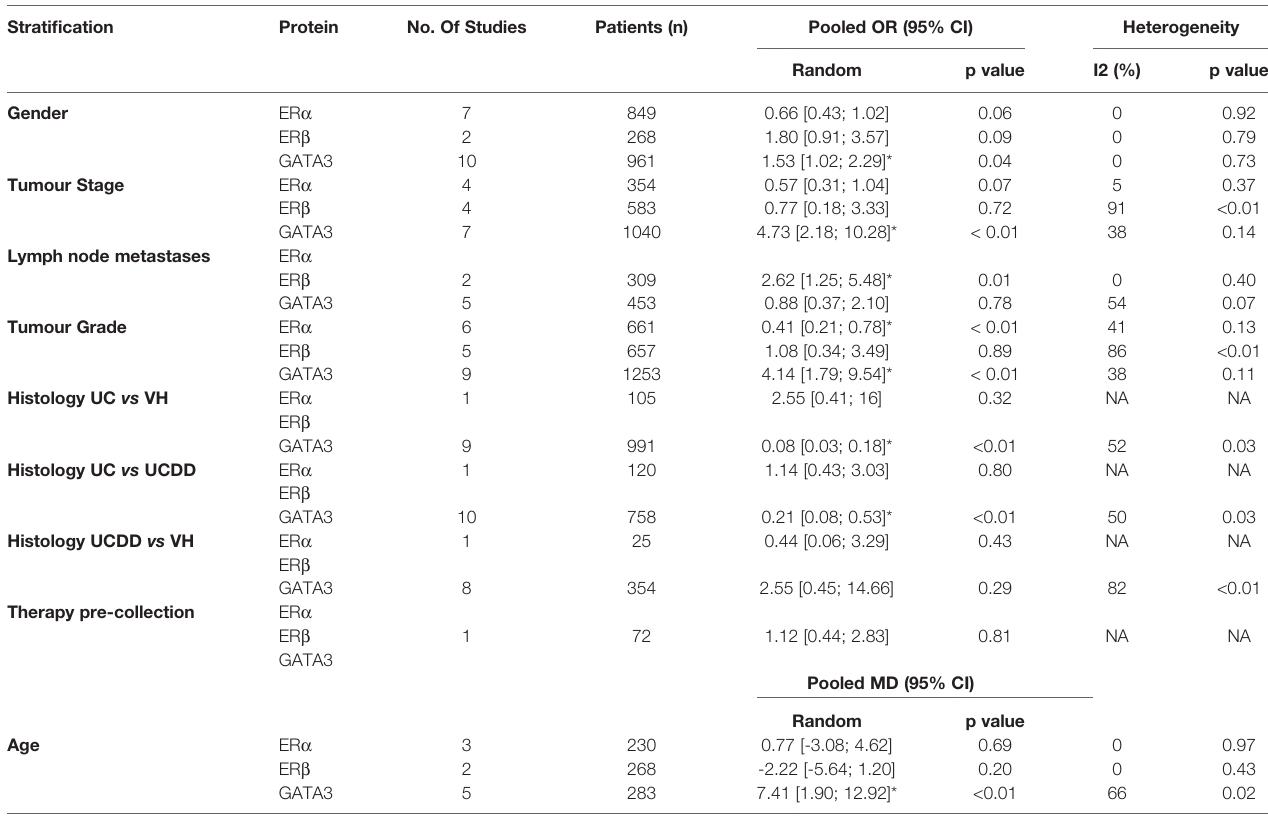
TABLE 4 | Meta-analysis summary table. Strati fi cation Protein